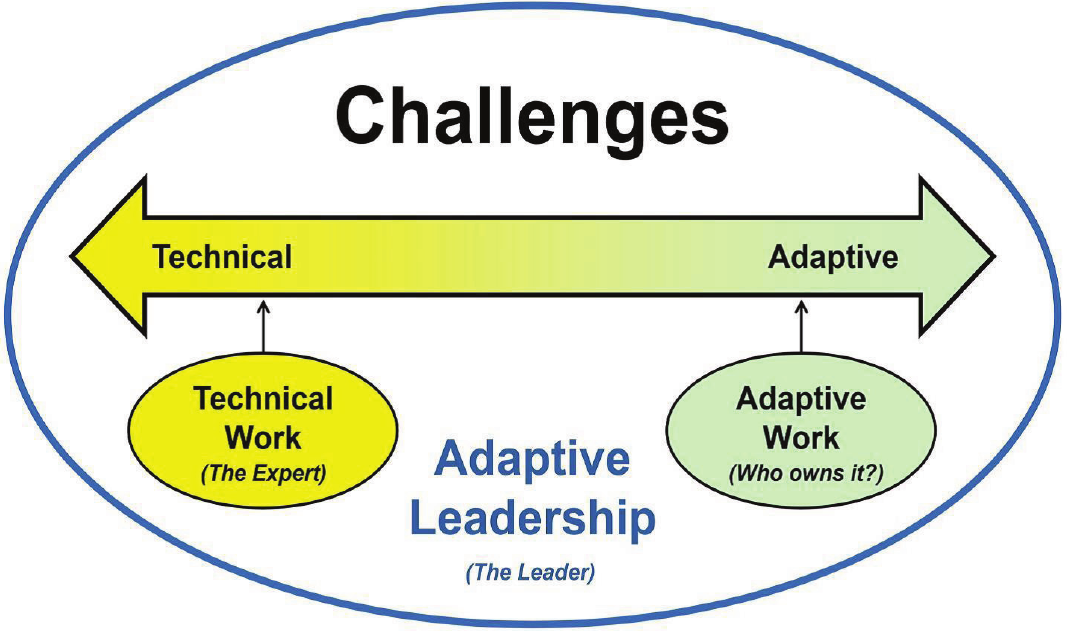
Figure 1. Adaptive Leadership